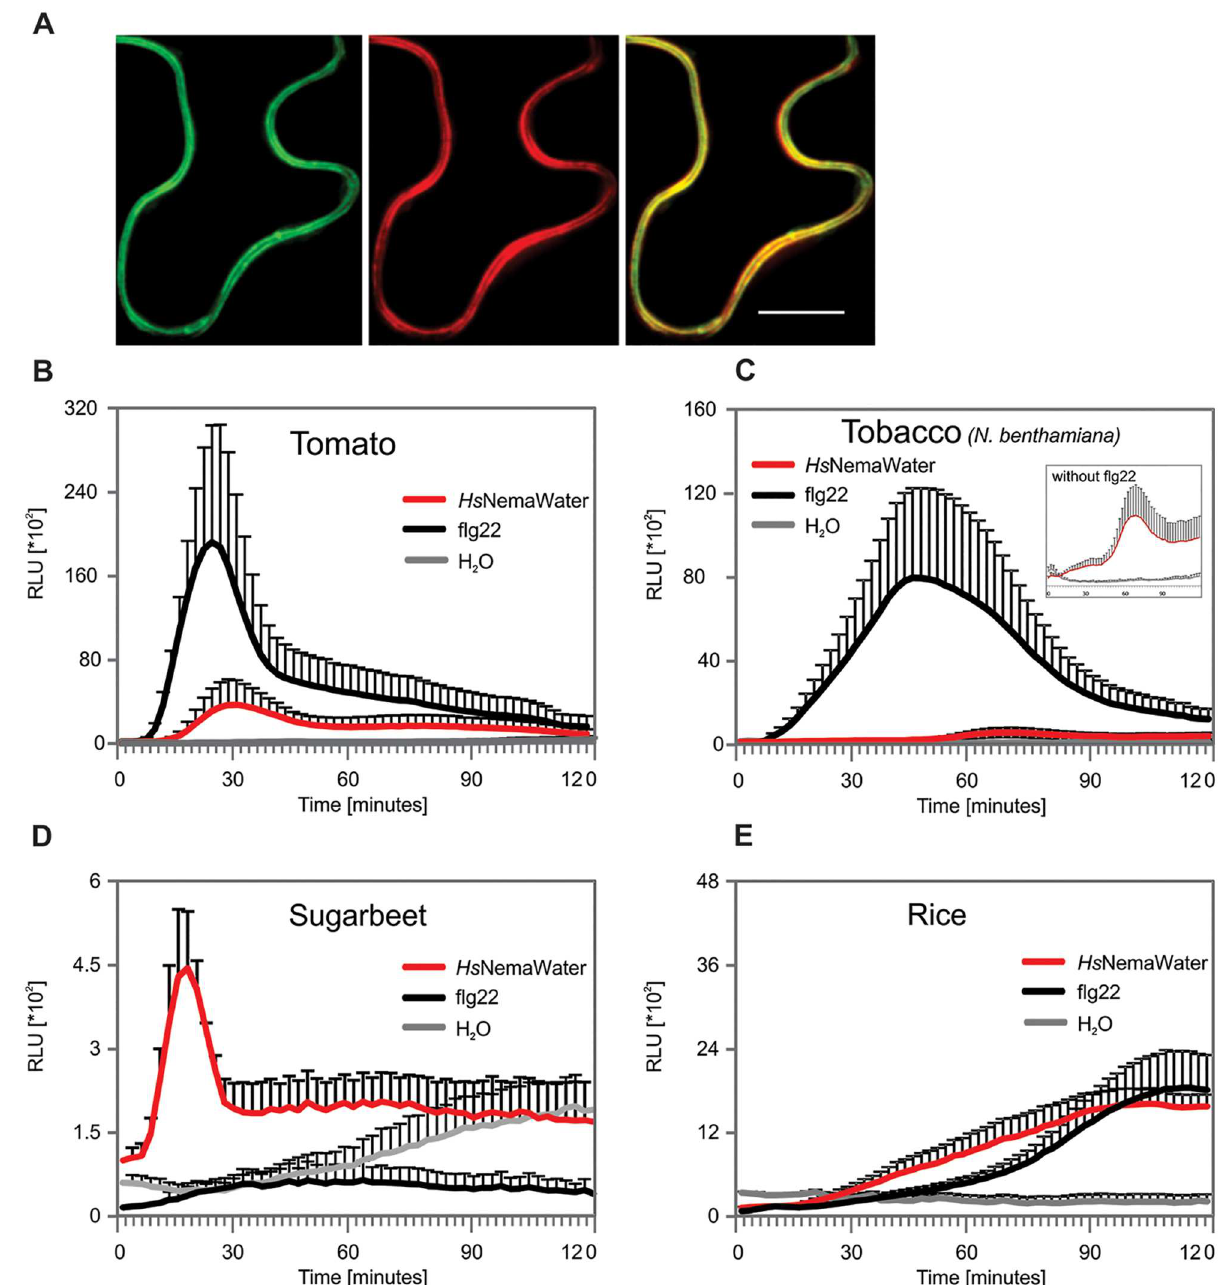
Fig 6. NILR1 is localised in plasma membrane. (A) Confocalmicroscopy of epidermisof Nicotiannabenthamiana transiently expressing 35S : NILR1-GFP and plasma membranemarker 35S : PIP2A-mCherry . Scale, 50 μ m. (B-E) Leaf discs from tomato (B), N . benthamiana (C), sugarbeet(D) and rice plants were treated with water, Hs NemaWater or flg22 and ROS burst was measuredusing L-012 basedassay from 0 to 120 min. Bars represent mean ± SE for three technicalreplicates. Experiment was repeatedthree times with same results. RLU, relative light